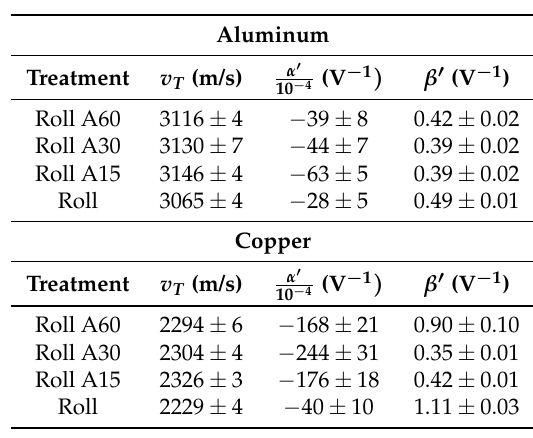
Table 2. Acoustic parameters, both linear and nonlinear, obtained for each group of samples compared and contrasted. Nonlinear parameters α (cid:48) and β (cid:48) exhibit a considerably higher change from sample to sample than the linear parameter v T . Errors are obtained by standard deviation of ten measurements with each method. See text for symbol definition.